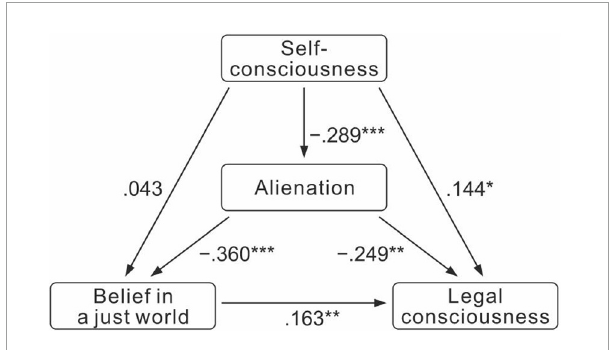
FIGURE1 Path analysis diagram of self-consciousness, alienation, belief in a just world and legal consciousness. ** p < 0.01 and *** p < 0.001.